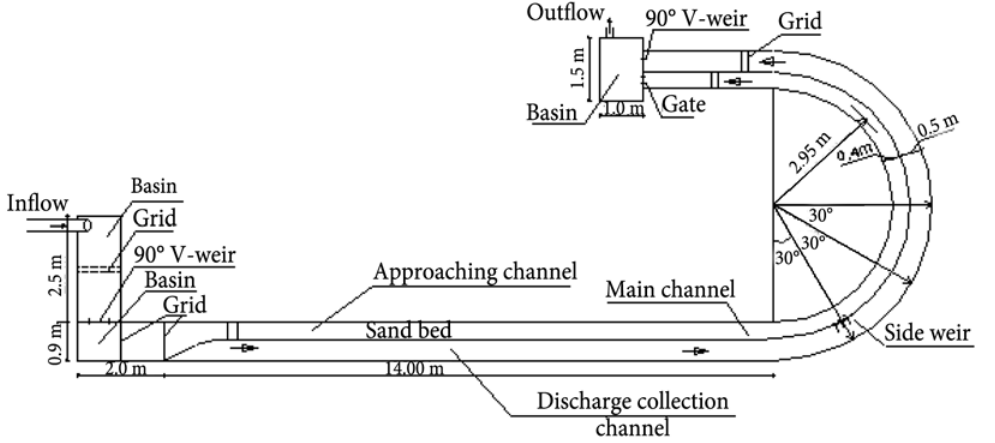
Fig. 3. Plan of test